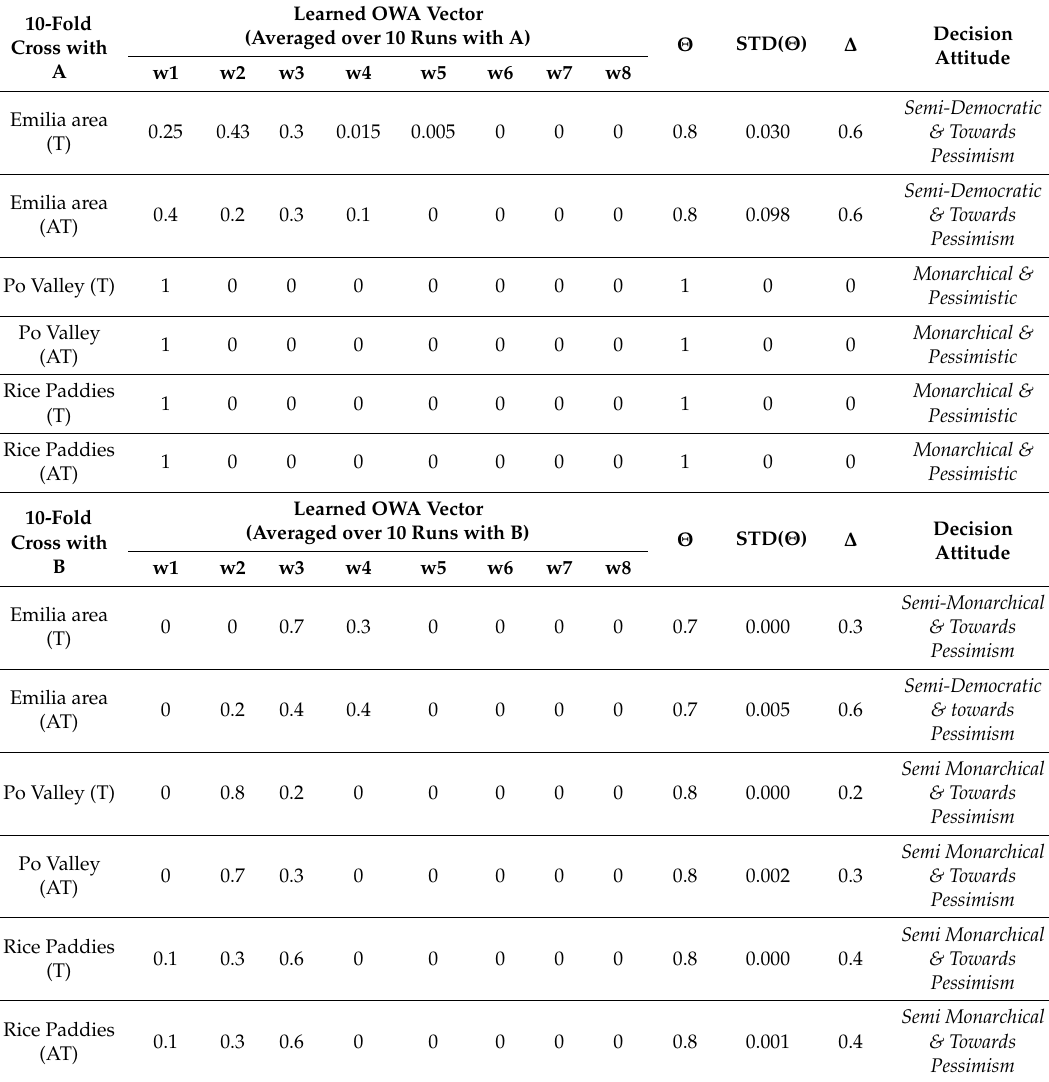
Table 6. Learned weighting vectors of the OWA operator in each ROI averaged over the 10 runs of both the typical (T) and atypical (AT) 10-fold cross validation for experts A and B. The table also reports the values of the approximated weighting vector, the average ORness ( Θ ), the ORness standard deviation (STD( Θ )), the dispersion ( ∆ ) and correspondent decision